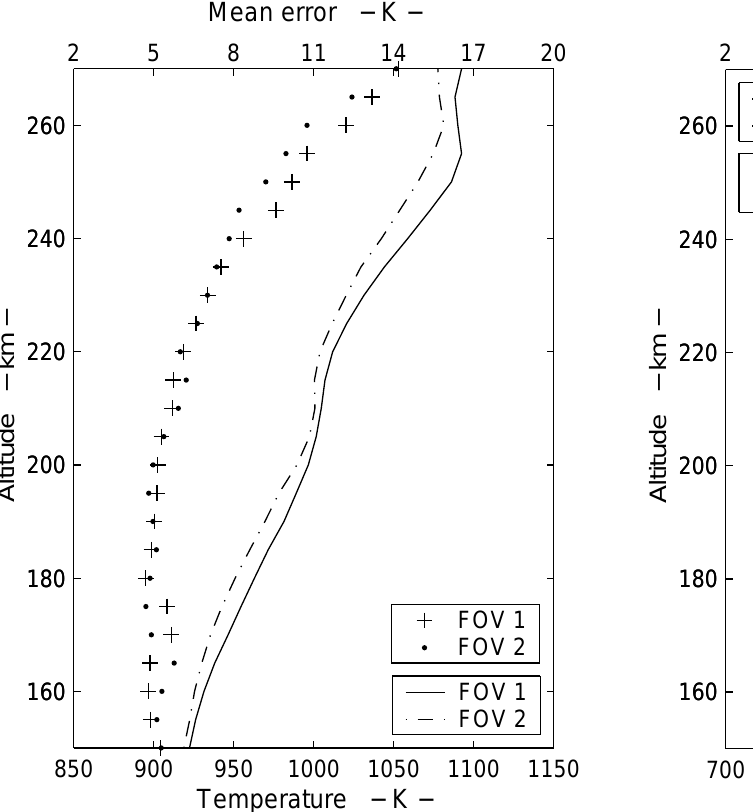
Fig. 3. Mean temperature profiles for the two FOVs on day 378. The mean errors are indicated by dots and crosses, and refer to the upper horizontal scale. They are the smallest around the altitude of the maximum of the O( 1 D)